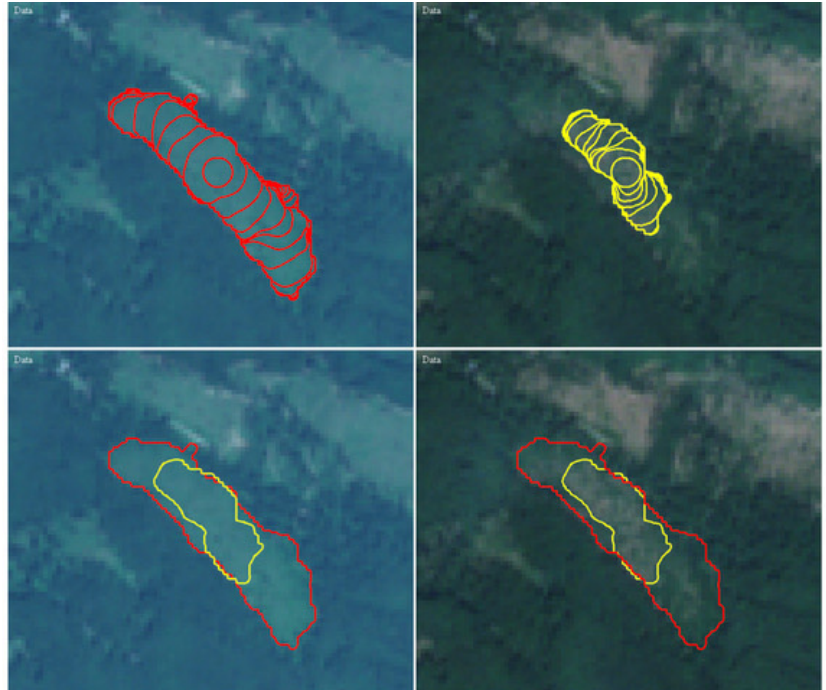
Figure 11. The example of grassland habitat segmentation. The top left image shows segmentation (red) in the original data from 2015. The top right image shows segmentation (yellow) in the updated data from 2019, where succession is visible. The bottom row compares visually the final segmented areas illustrated on both original and updated data. Table 4. Characteristics of the final segmentation curves from Figure 11 final segmented areas, showing their difference in area, perimeter, isoperimetric ratio and classical (HD) and mean (MHD) Hausdorff distances of two segmentation curves.